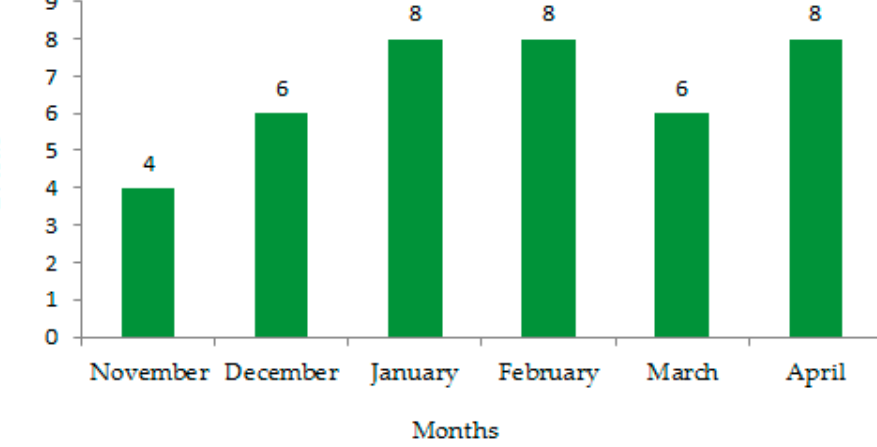
Figure 3. Monthly distribution of the 40 extreme event cases considered.